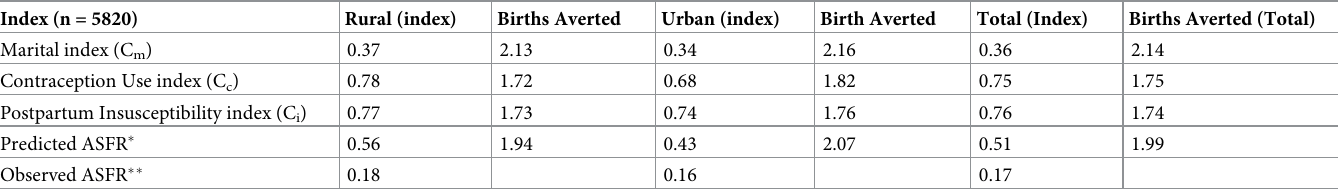
Table 3. Proximate determinants indices of adolescent fertility, Kenya,